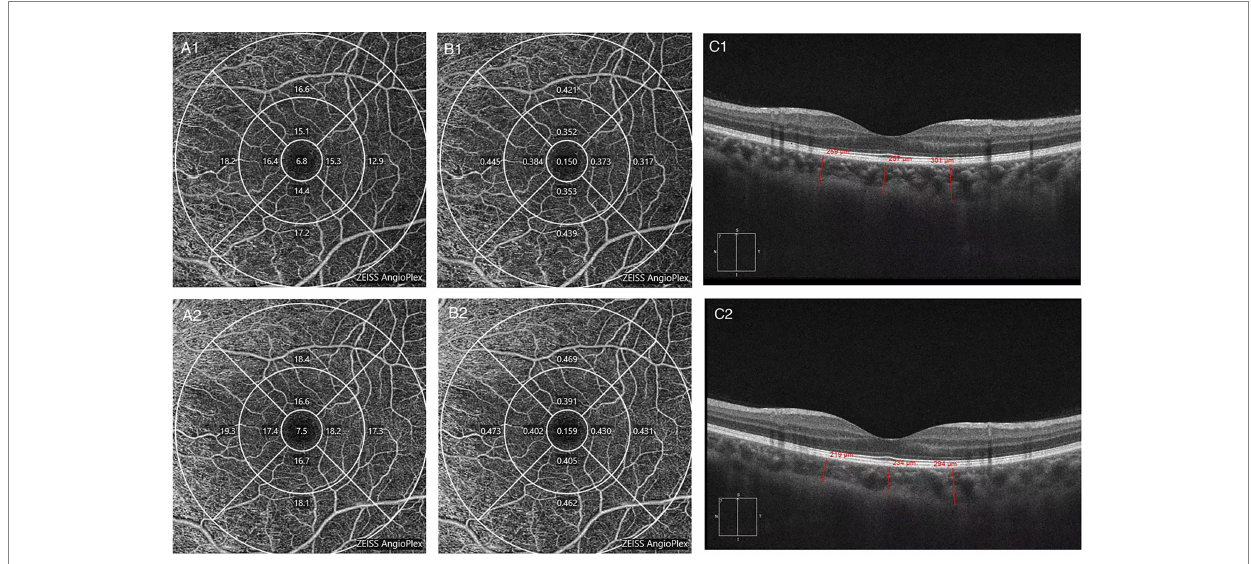
FIGURE 3 The changes in a patient imaged with optical coherence tomography angiography (OCTA) in the active phase of acute myeloid leukemia (AML) and after remission. (A1) Macular vessel density before treatment. (A2) Macular vessel density after treatment. (B1) Macular perfusion density before treatment. (B2) Macular perfusion density after treatment. (C1) Choroidal thickness before treatment. (C2) Choroidal thickness after